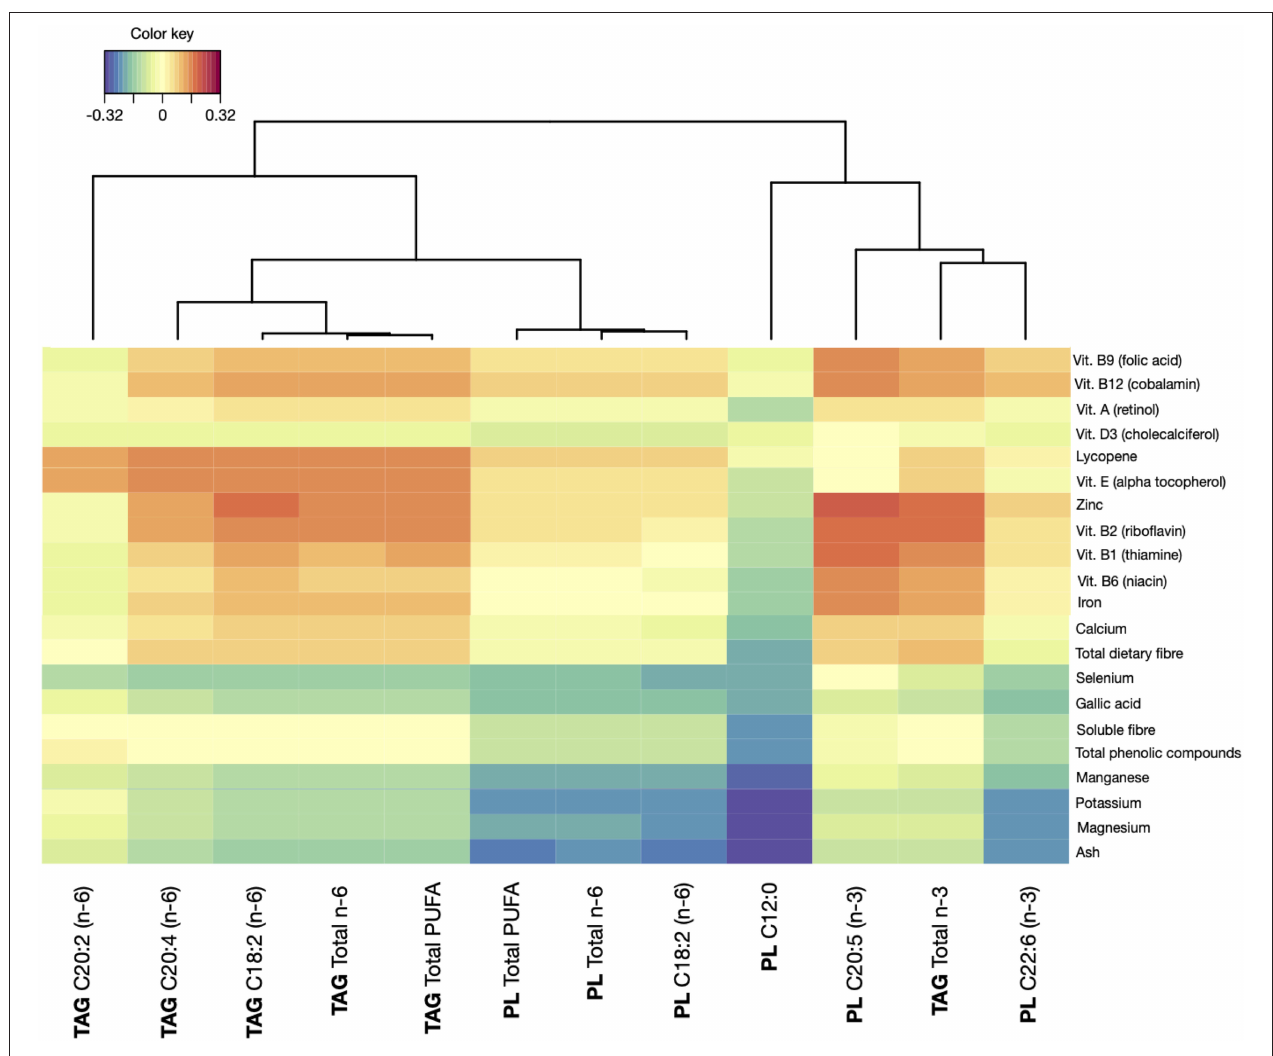
FIGURE 2 | Correlations between dietary compounds and levels of fatty acids (FAs) series in breast milk samples. TAG, triacylglycerol molecules; PL, phospholipid